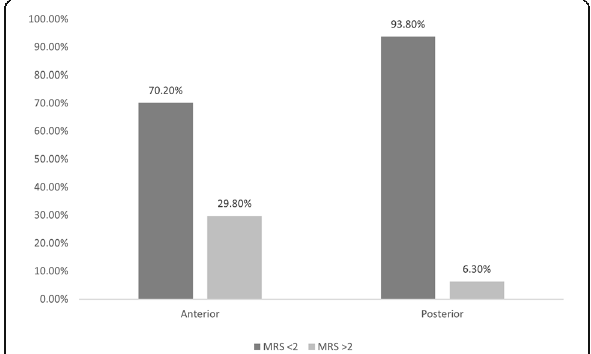
Fig. 3 The distribution of mRS within each study group and between the two